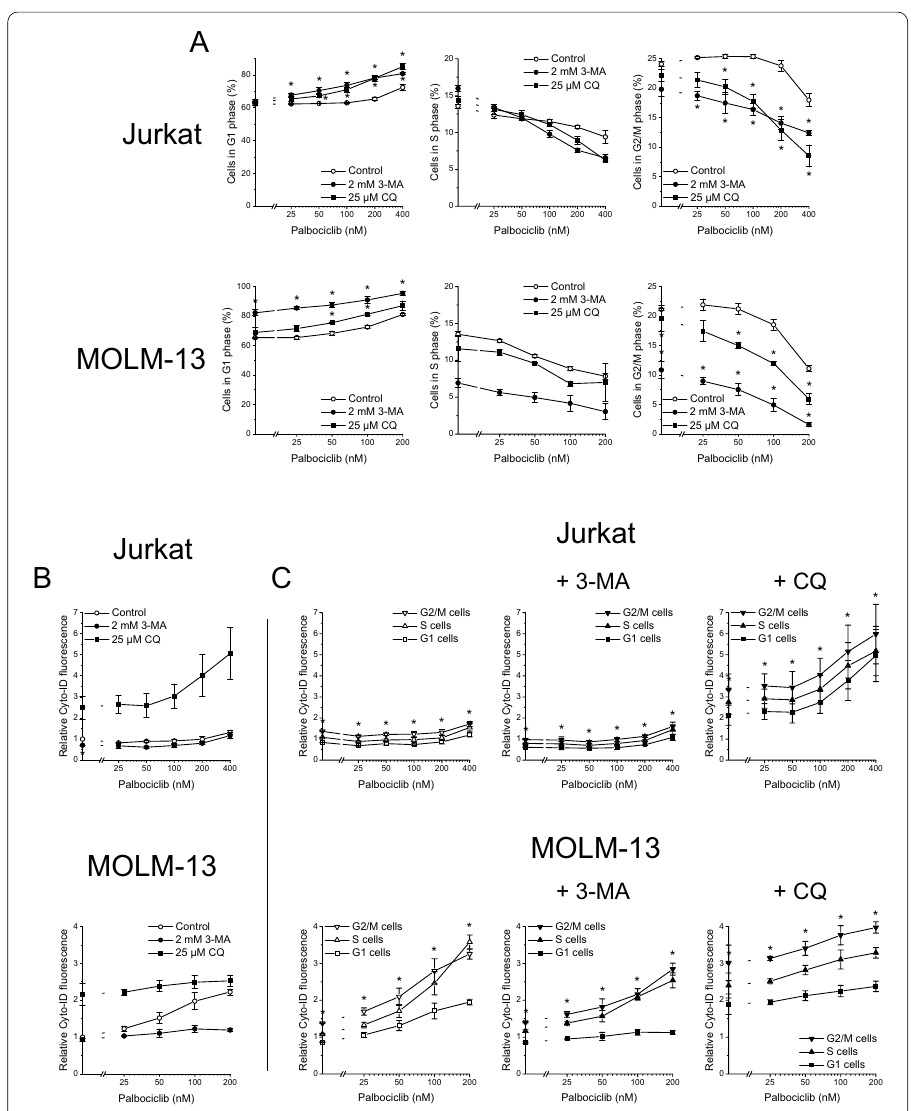
Fig. 3 Autophagy inhibition enhances palbociclib‑induced G1‑phase arrest. Cells were exposed to palbociclib with or without autophagy inhibitors for 48 h. Autophagy and cell cycle phases were determined by flow‑cytometric analysis of Cyto‑ID DRAQ5 double‑stained cells. A Effect of palbociclib on cell cycle + distribution. B, C Effect of palbociclib on autophagy. Cyto‑ID fluorescence intensities were normalized to the mean Cyto‑ID fluorescence intensities of untreated cells. Mean SEM of three independent measurements is ± shown (A: 3‑MA or CQ versus control, C: G1 cells versus G2/M cells: * P <